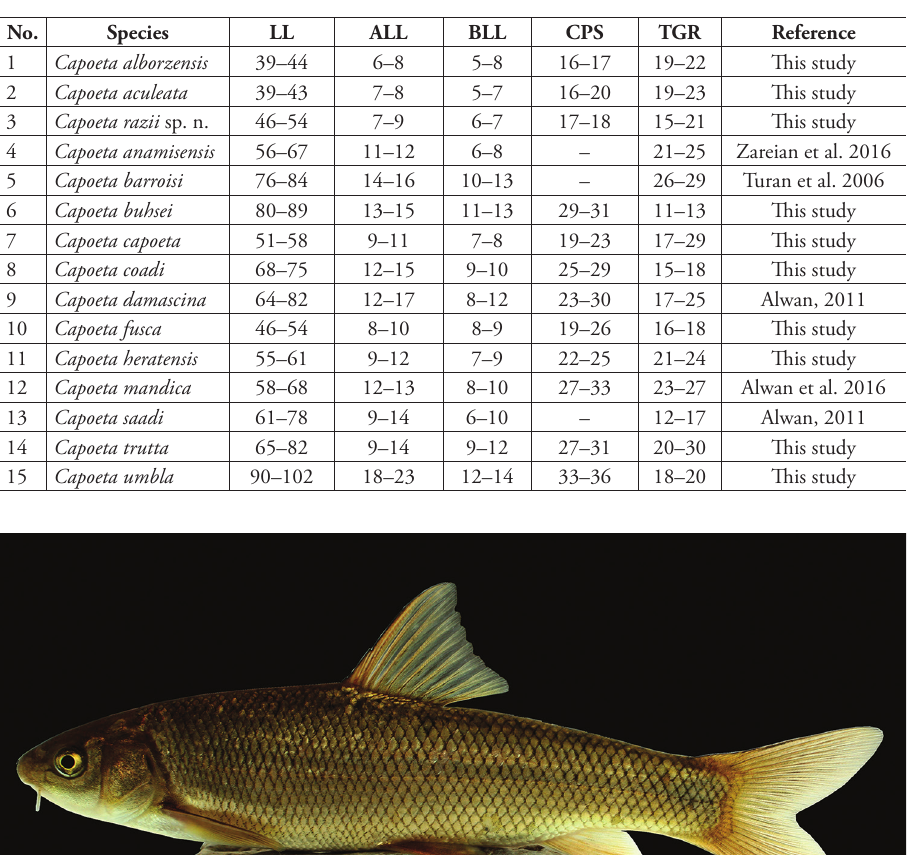
Table 8. Range of meristic features of Iranian Capoeta species.